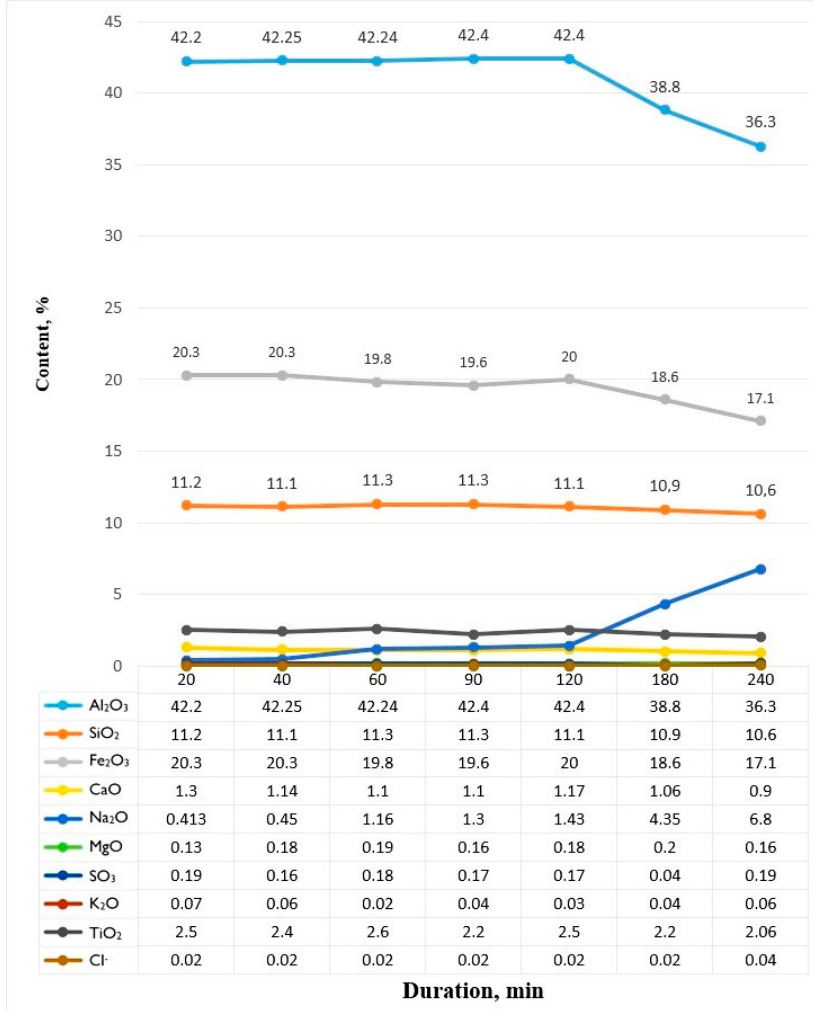
Figure 5. The chemical composition of bauxite samples depending on the duration of activation at the temperature of 120 °C.